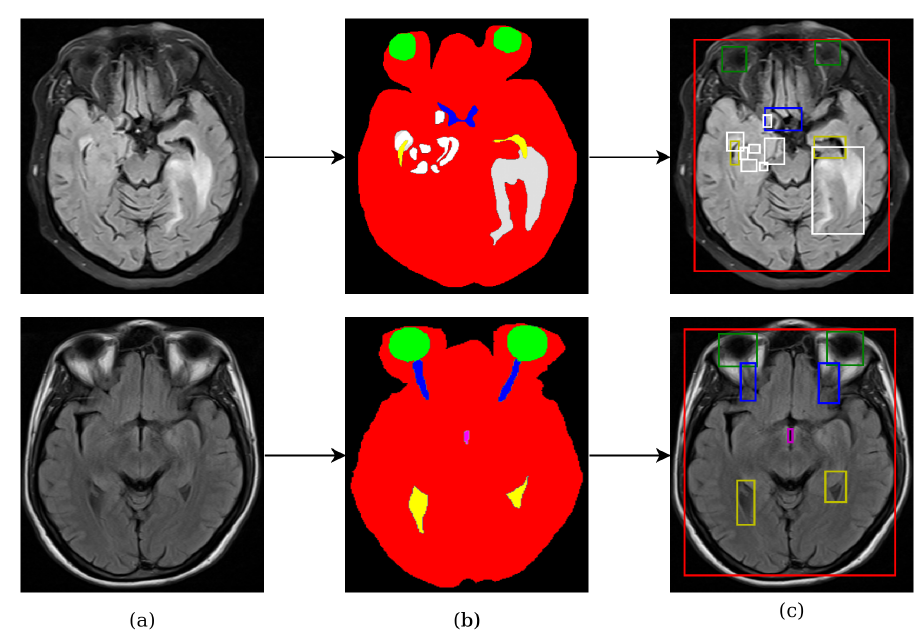
Figure 1. An example of the dataset preparation: ( a ) an original FLAIR slice; ( b ) segmented by experts; and ( c ) the extracted anatomical objects (red: ROI, green: eye, blue: optic nerve, yellow: lateral ventricle, magenta: third ventricle, white: whole